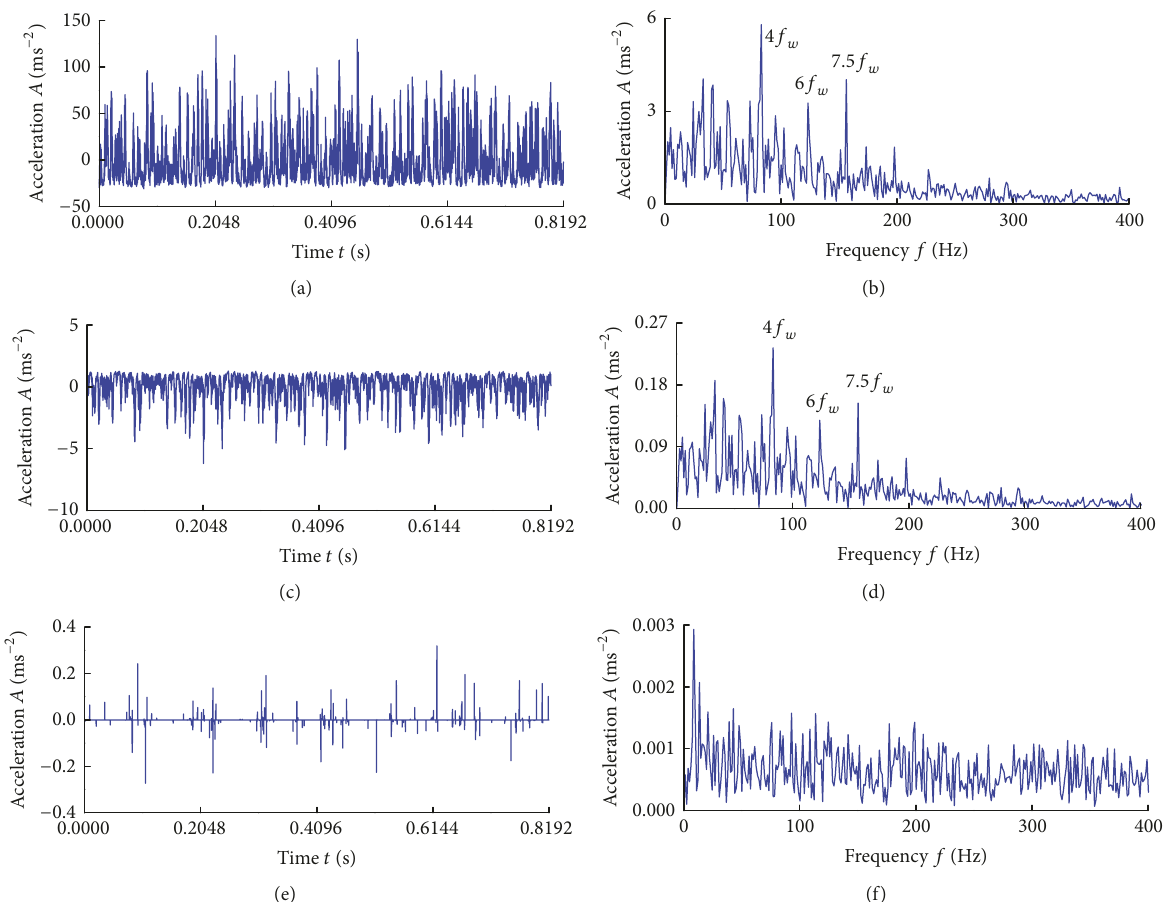
Figure 20: The intrinsic envelope of wheelset bearing vibration extracted by the impulse-envelope manifold corresponding to atom 2: (a) the impulse-envelope with Isomap, (b) the Hilbert envelope spectra of (a), (c) the impulse-envelope with LLC, (d) the Hilbert envelope spectra of (c), (e) the impulse-envelope with LTSA, and (f) the Hilbert envelope spectra of (e).